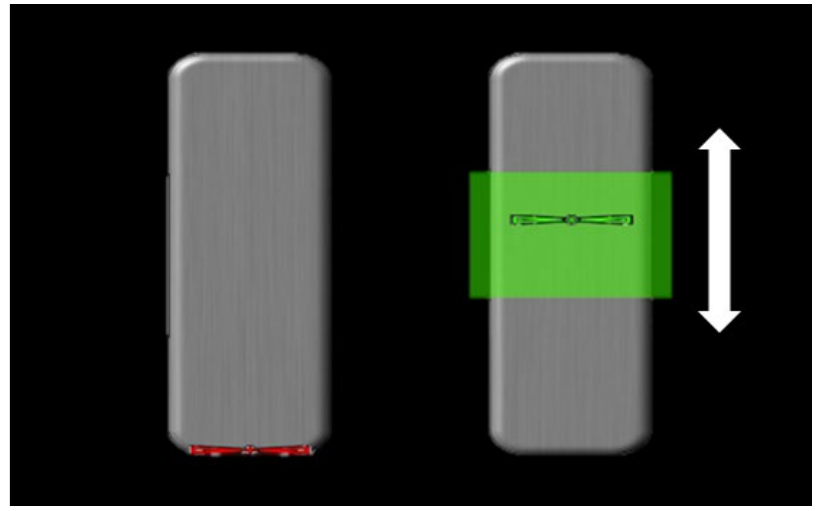
Figure 2. Pedals Chase© Level 2. Pedals Emergency Stop©